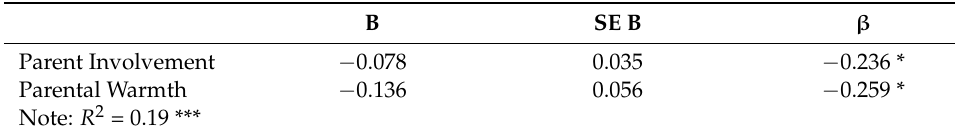
Table 4. Regression for boys—behavior